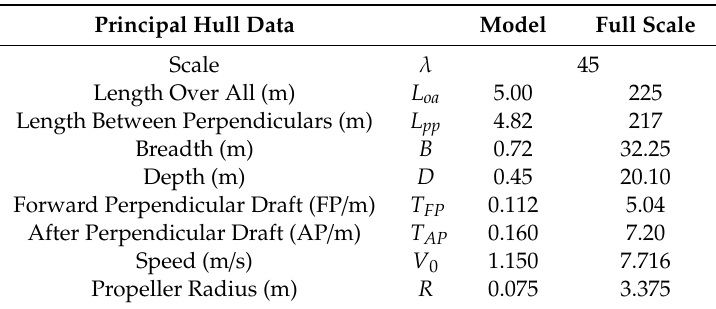
Table 2. PIV test conditions under the ballast condition.